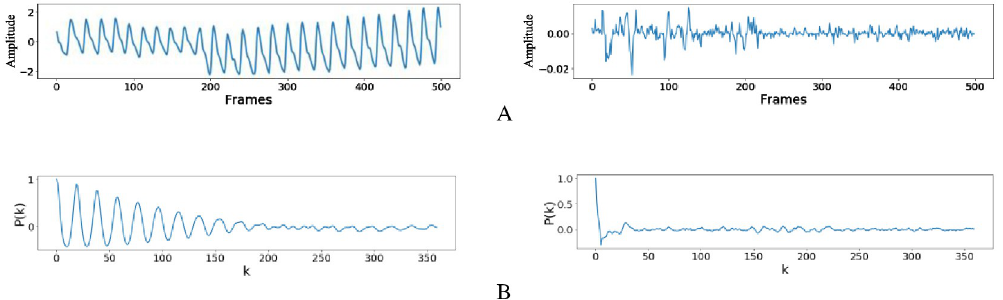
Fig 8. The autocorrelation of HR-related signal and noise signal. A: The HR-related signal(left), the noise signal(right). B: The autocorrelation of HR-related signal(left), The autocorrelation of noise